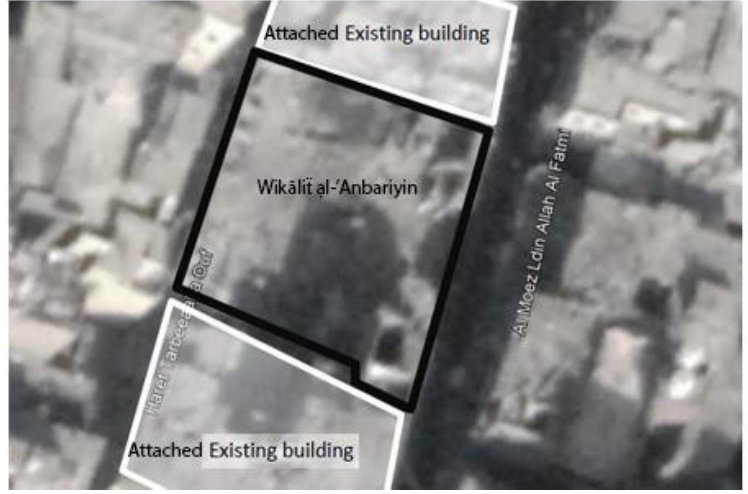
For another interviewee, the essence of Wikāliẗ ạl - ’Anbariyin is the courtyard. He used his shop furniture to explain its rectangular shape. He mentioned the enclosure of the courtyard, which provided him with a sense of intimacy and privacy. He added that this inner courtyard influenced communication and connectivity between the workers, where a worker could call the other. The courtyard was their focal point and gathering space for eating and other activities. It was their own lived space. The courtyard also connected Wikāliẗ ạl - ’Anbariyin to the other attached buildings. Therefore, workers and visitors could easily access Wikāliẗ ạl - ’Anbariyin and move freely between the three buildings (Figures 11 and 12).